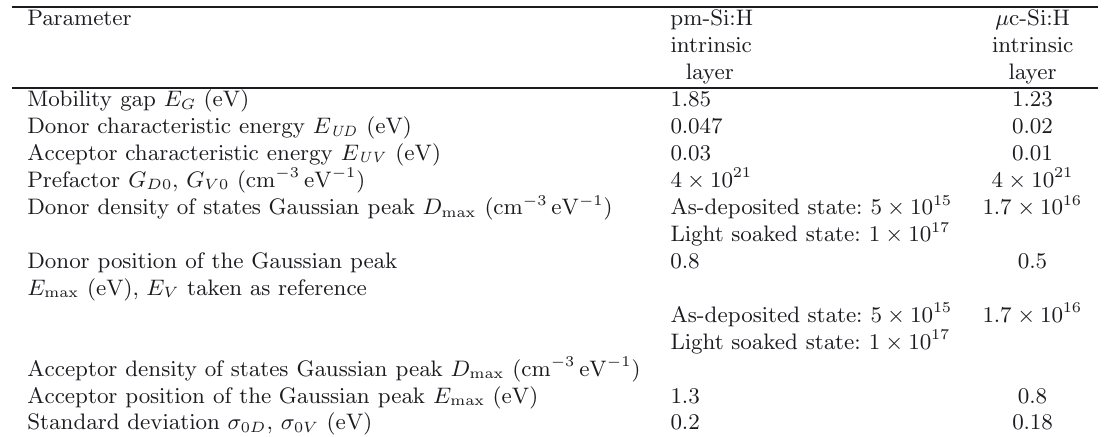
Table 1. Main electrical parameters of the pm-Si:H and μ c-Si:H intrinsic layers introduced in the simulation.